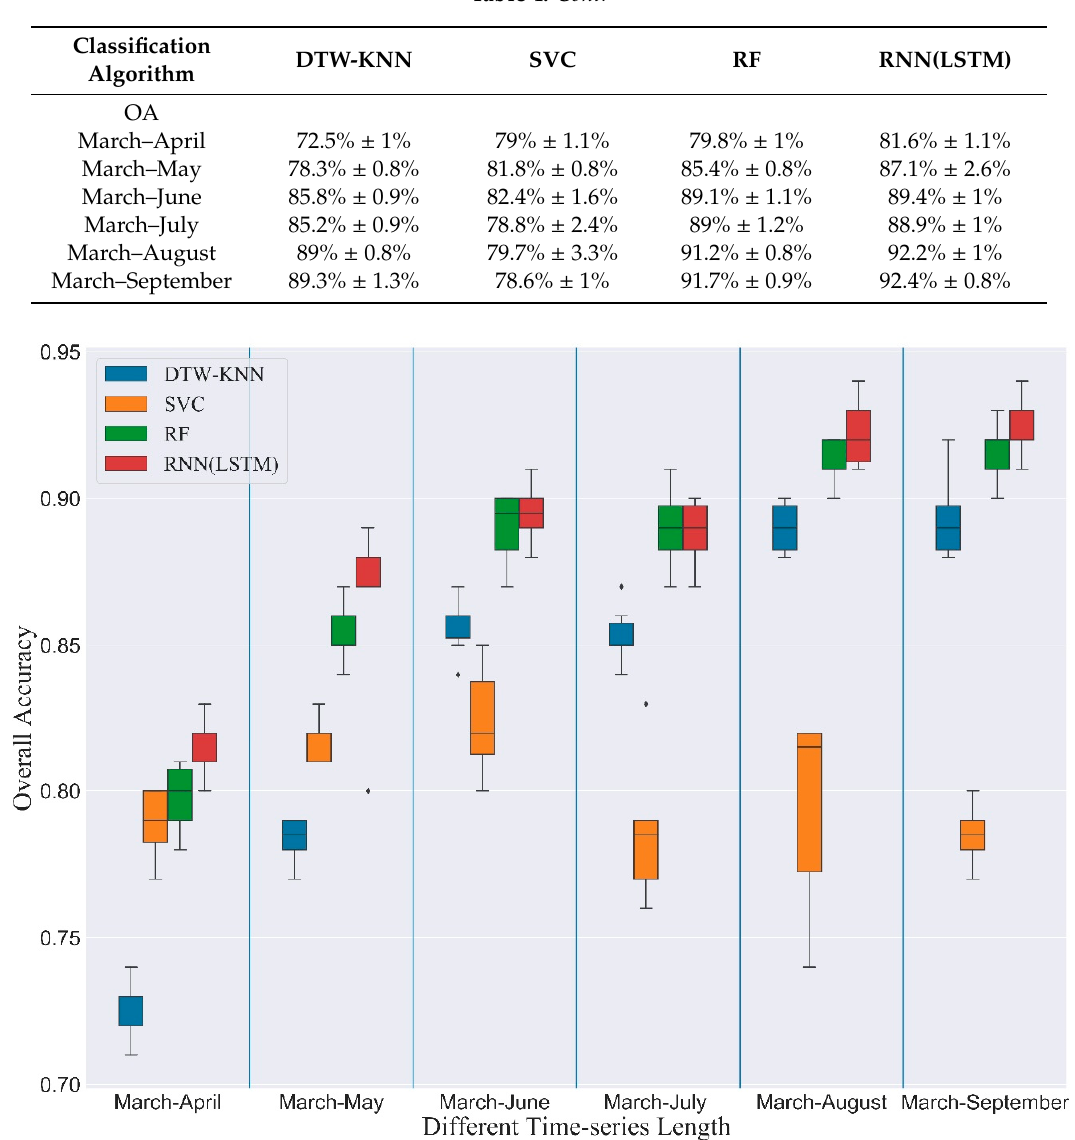
Figure 8. Box plots of the overall accuracy for KNN, SVC, RF, and LSTM.